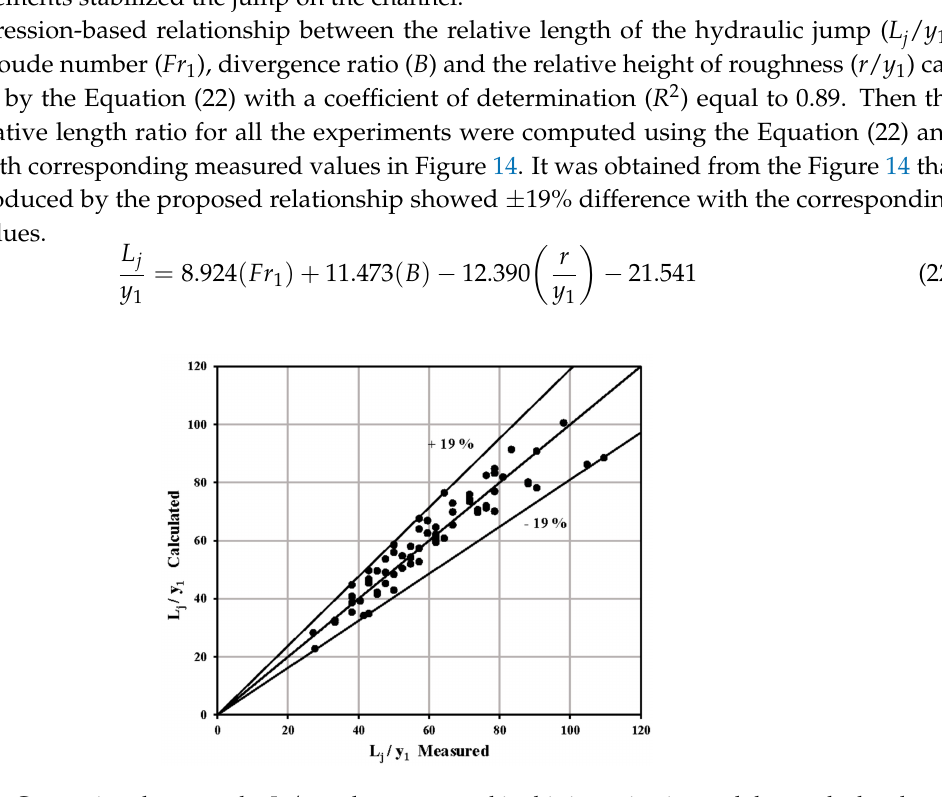
Figure 14. Comparison between the L j / y 1 values measured in this investigation and those calculated by Equation